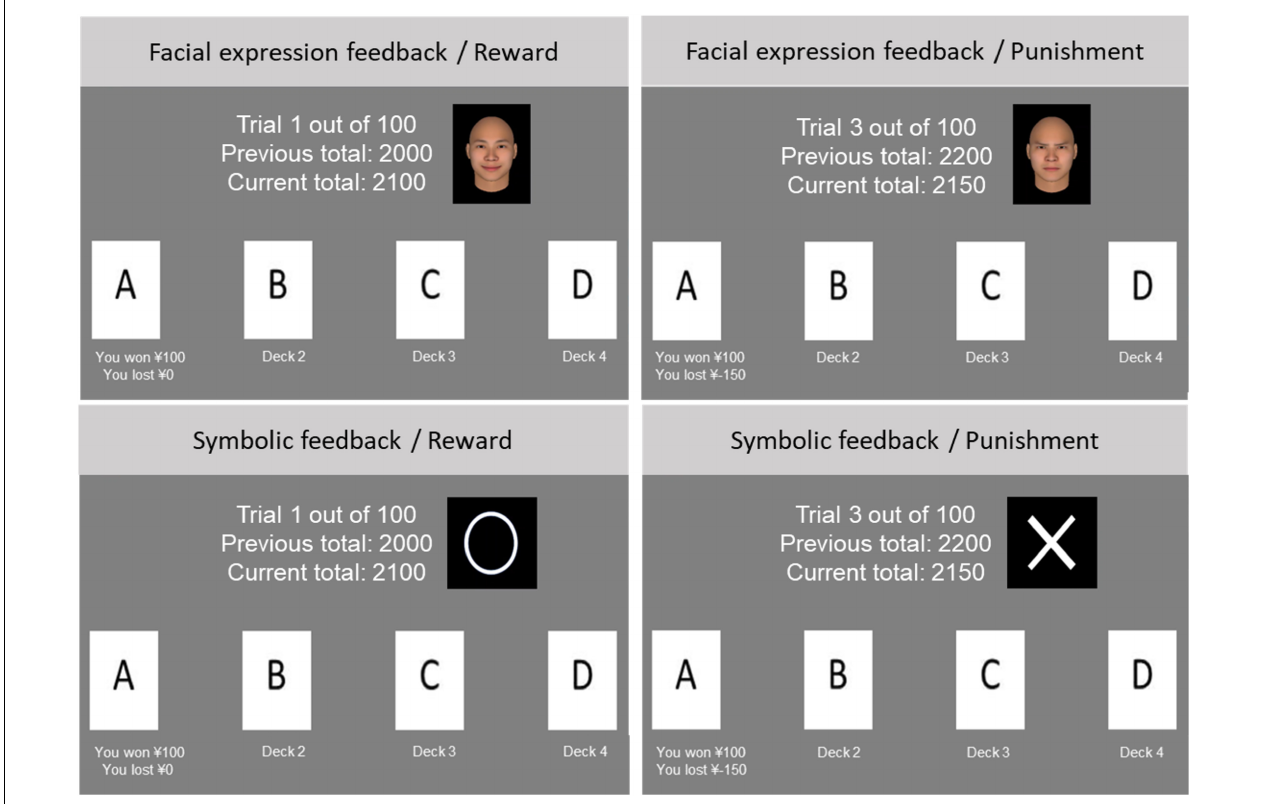
FIGURE 1 | Example feedback condition in the Iowa Gambling Task. The upper panel shows social feedback, whereas the lower panel shows symbolic feedback.